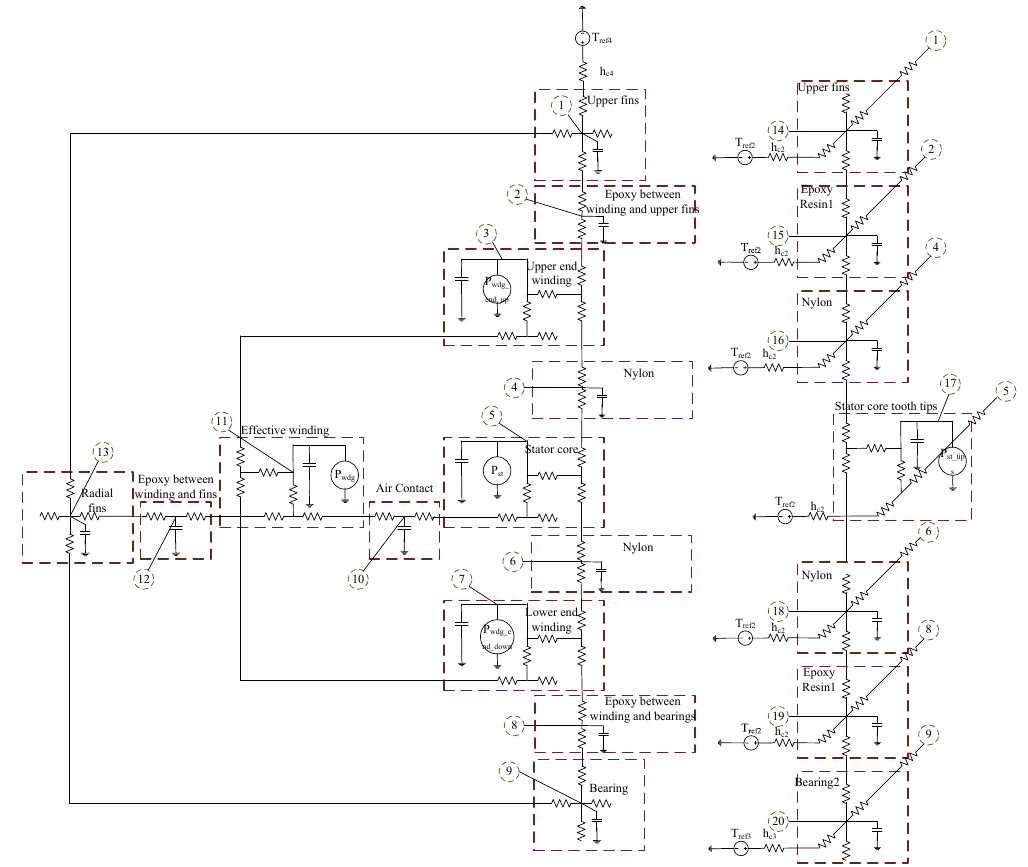
Figure 7. Lumped parameter thermal network (LPTN) of the